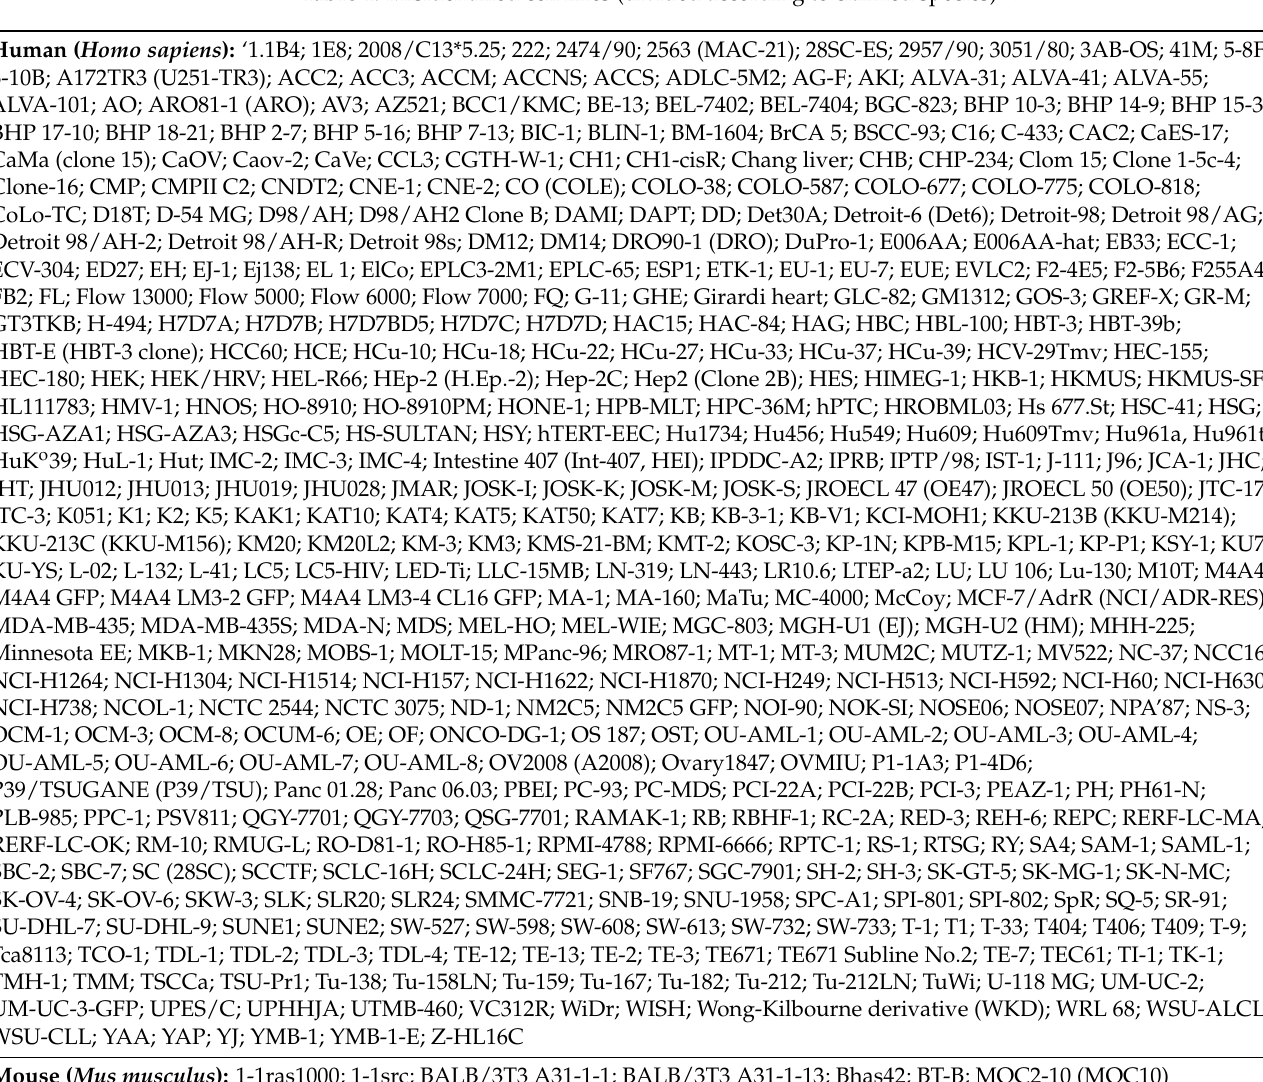
Table 4. Misidentified cell lines (divided according to claimed species) 1